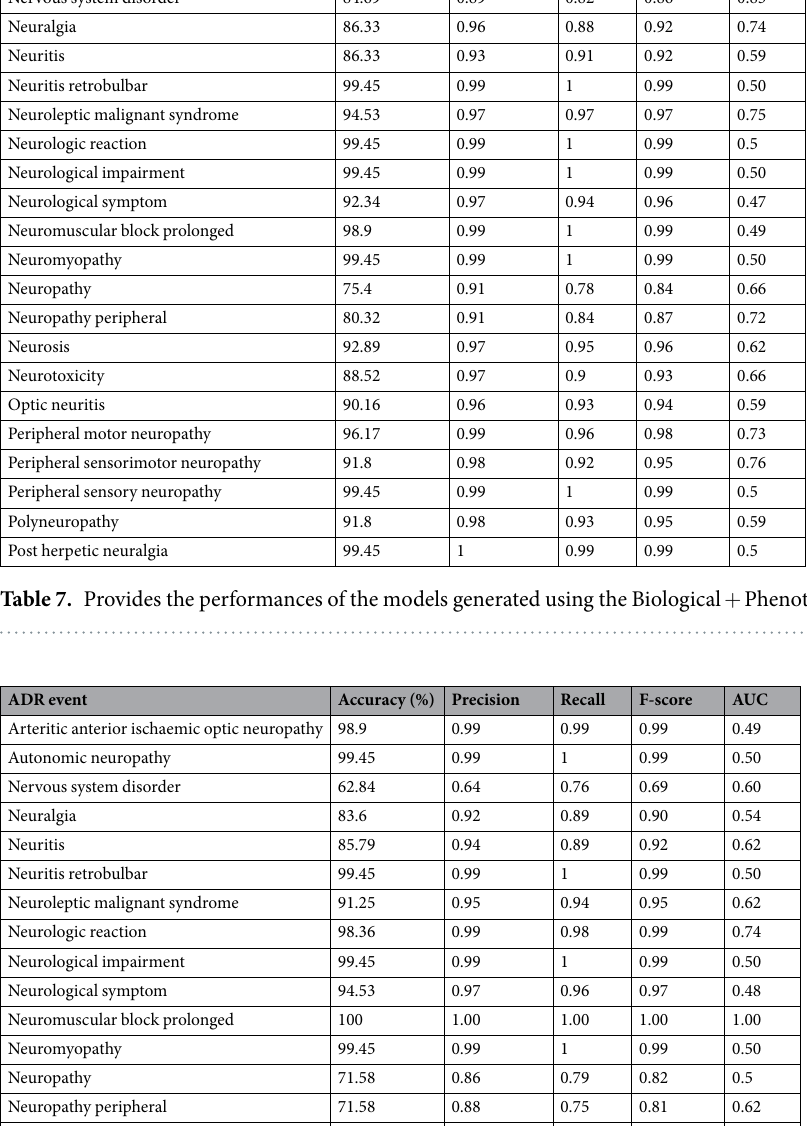
Table 8. Provides the performances of the models generated using the Biological + Chemical